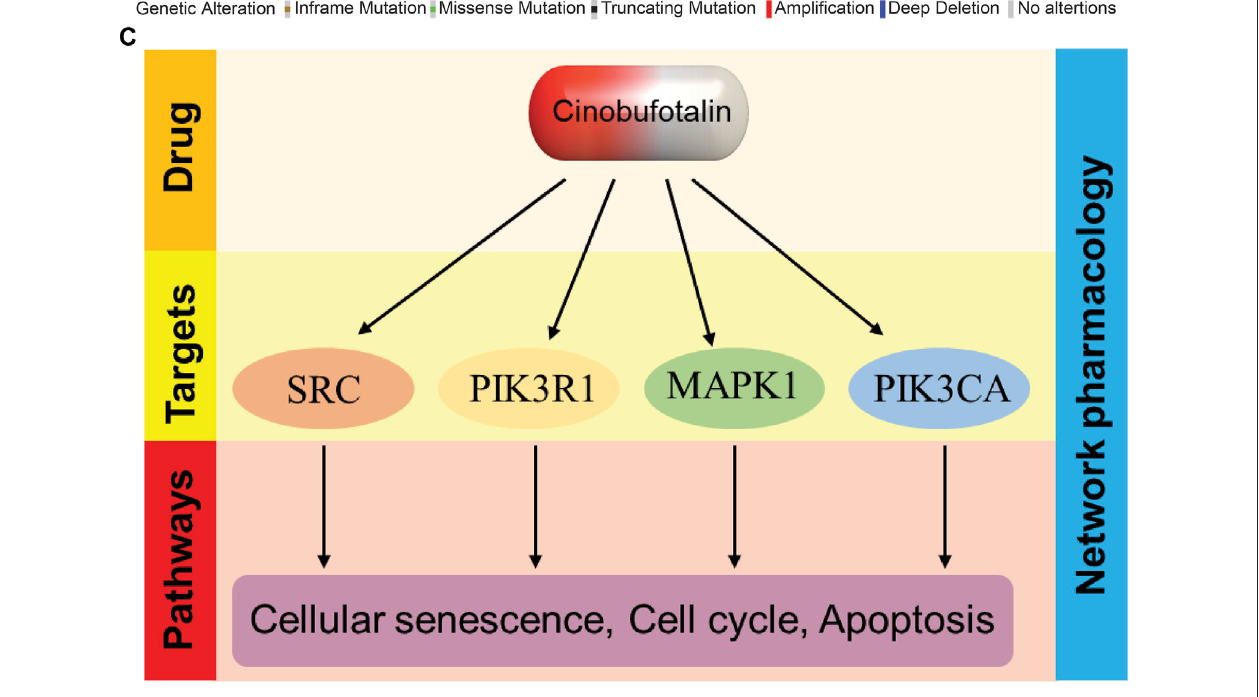
FIGURE7| The expression and mutation frequencyofkeytargets in coloncancer (A) RepresentativeIHC stainingofSRC,PIK3R1, MAPK1 and PIK3CAin COAD fromHPA database (B) Thetypesand frequencyofmutationsofSRC,PIK3R1,MAPK1andPIK3CAinCOADpatients (C) Proposedmodel: Theroleandmechanismof cinobufotalin against